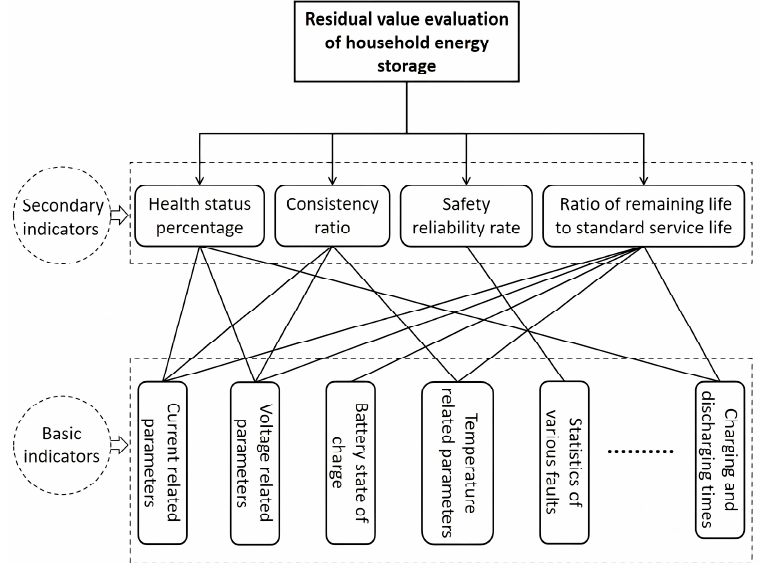
Figure 4. Household energy storage recovery residual value evaluation index.